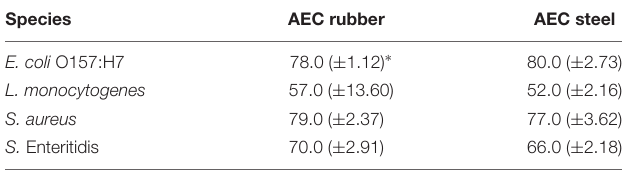
TABLE 3 | Absolute coefficient of RCI effectiveness (AEC) (%) Species AEC rubber